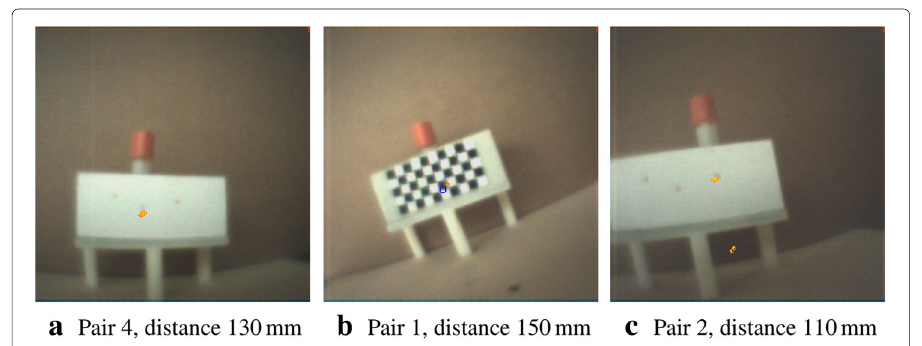
Fig. 20 Some error cases. The exposure time for these measurements is 16 s. a Overestimating the true distance: estimated distance 150 mm, the augmentation is slightly off. b Underestimating the true distance: estimated distance 110 mm, the discrepancy is visible. c Pathologic case: a ghostly (false) augmentation in the foreground due to high scattering not properly